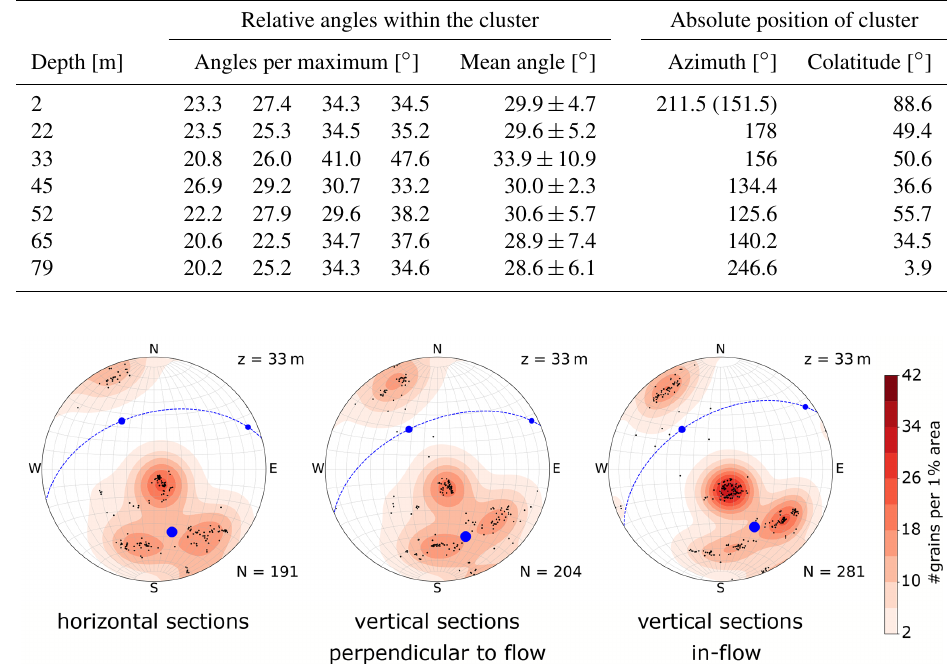
Figure 6. Stereo-plots (lower-hemisphere Schmidt equal-area projection) for the three types of sub-samples (horizontal, east–west, south– north, from left to right) with annotations as in Fig. 5.